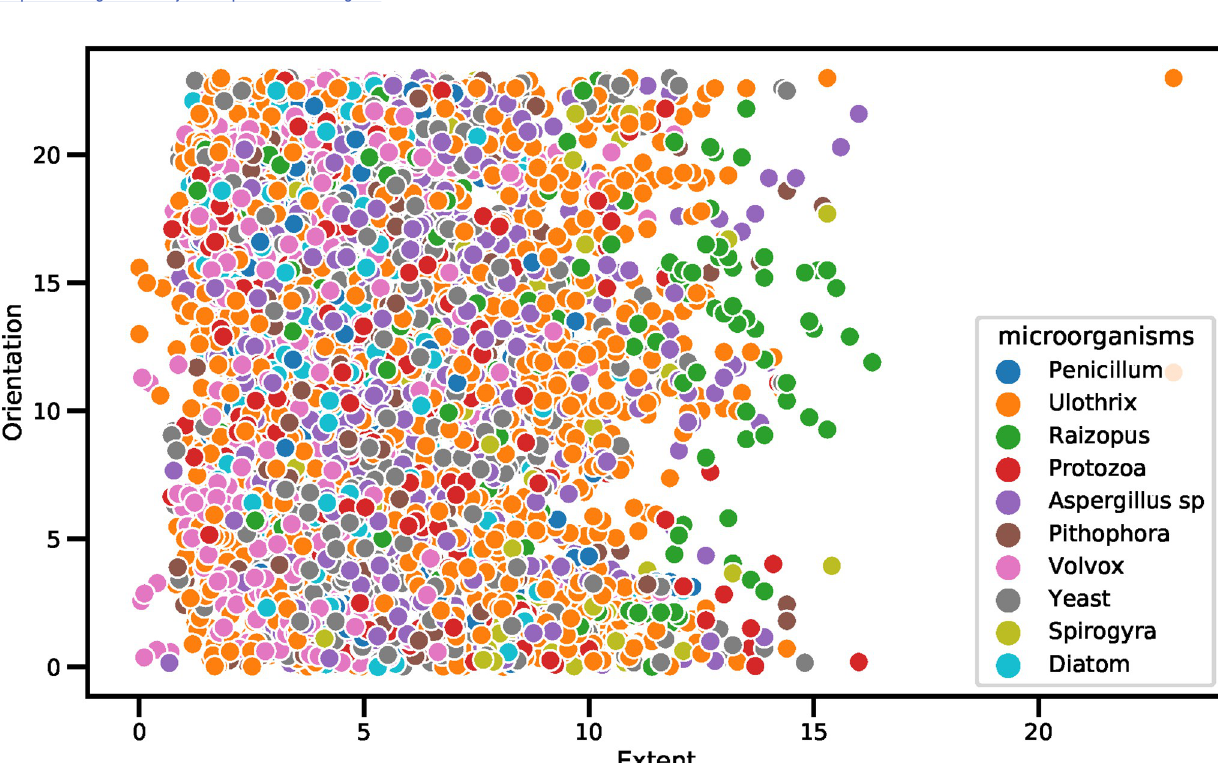
Fig 4. The scatter plot showing the distribution of features regarding Solidity and Eccentricity along with the target class.